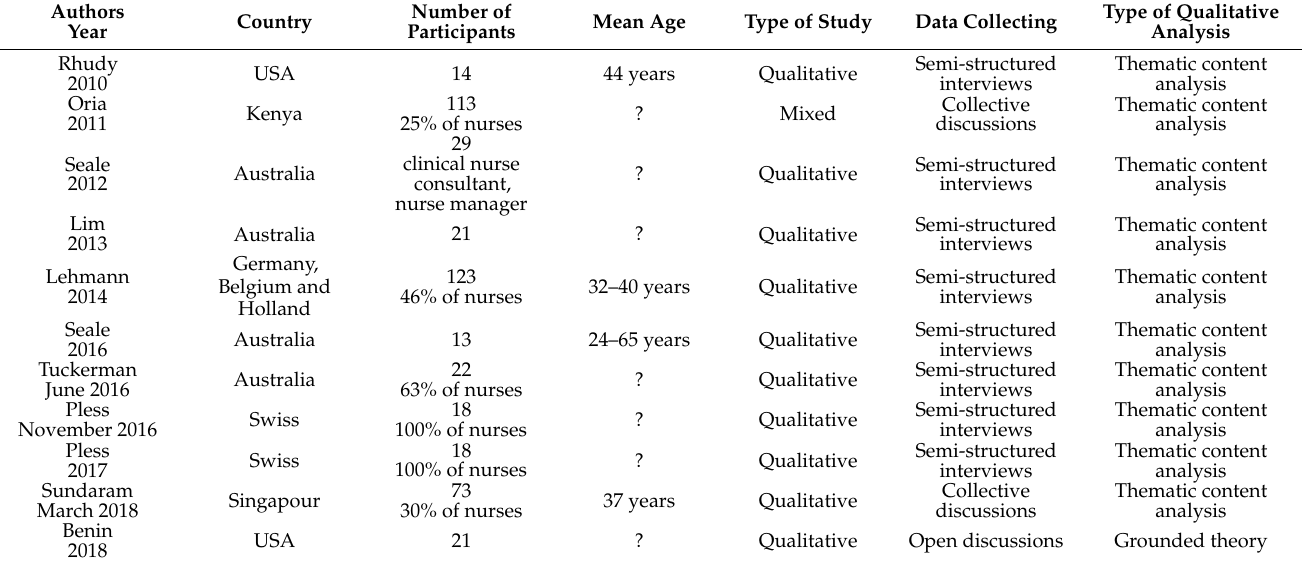
Table 1. Study characteristics: authors, countries, number of participants, mean age, type of study, and method of qualitative